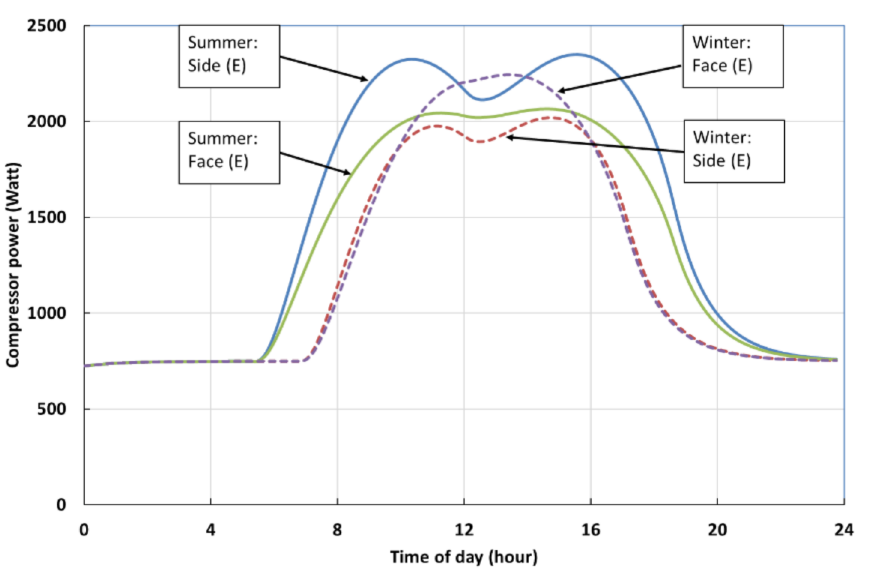
Figure 14. Compressor power required to maintain the cold storage at 5 ◦ C for orthogonal container orientations in mid-summer and mid-winter. Side (E) indicates the container side wall normal to the east, Side (W) indicates the container side wall normal to the west, Face (N) indicates the container face wall normal to the north, Face (S) indicates the container face normal to the south, and Roof indicates the roof wall of the container, which is normal to